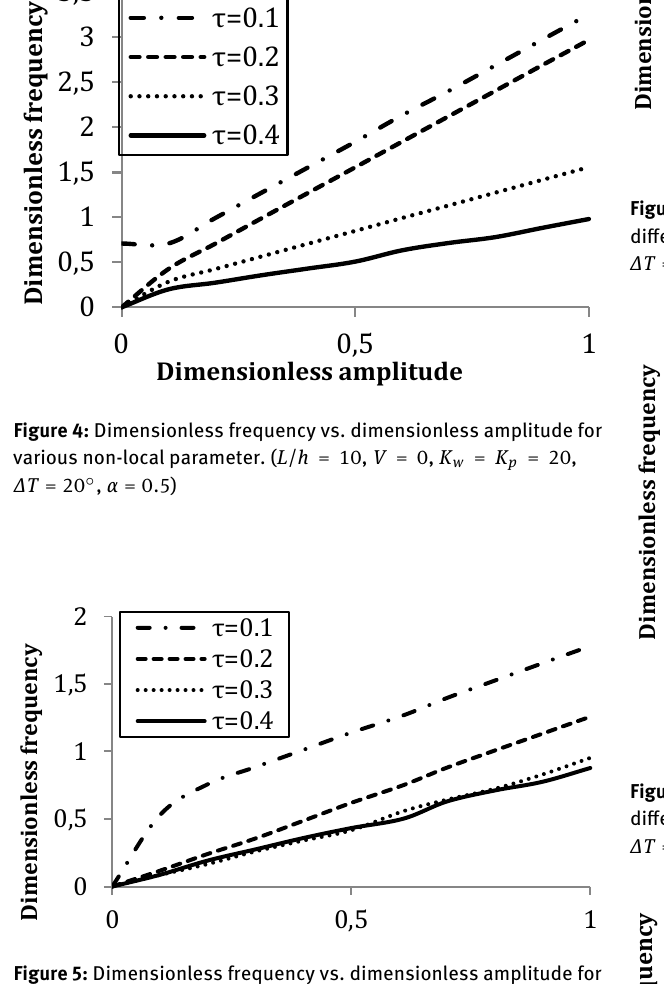
Figure 5: Dimensionless frequency vs. dimensionless amplitude for various non-local parameter. ( L / h = 20 , V = 0 , K w = K p = 20 , ∆T = 20 ∘ , α = 0.5 )